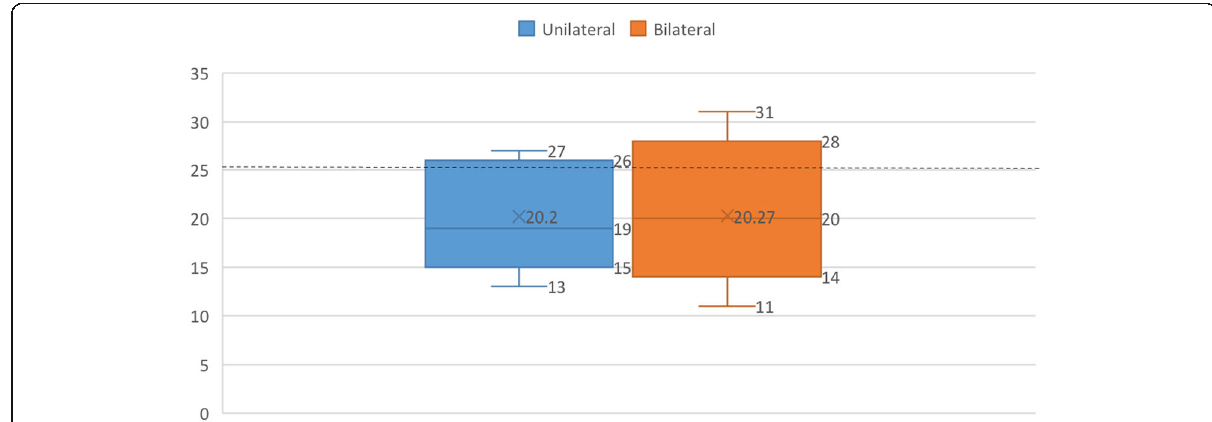
Fig. 3 Box plots of the auditory processing section in children with unilateral and bilateral